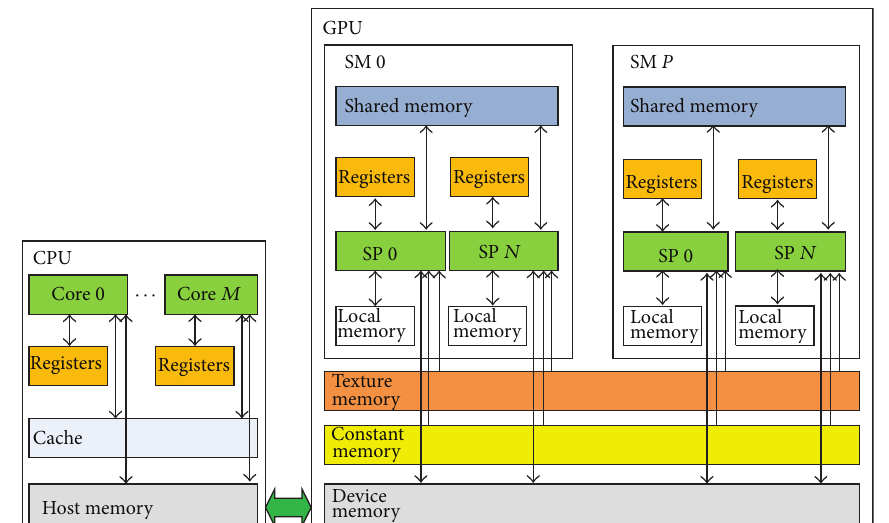
Figure 3: Typical architecture of GPU.